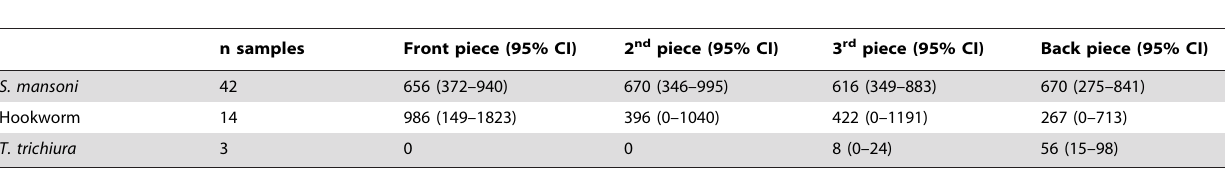
Table 3. Mean FECs (expressed as EPGs) in different stool pieces along the length axis of whole-stool samples, among 59 helminth-positive participants from Azaguie´, Coˆte d’Ivoire, in